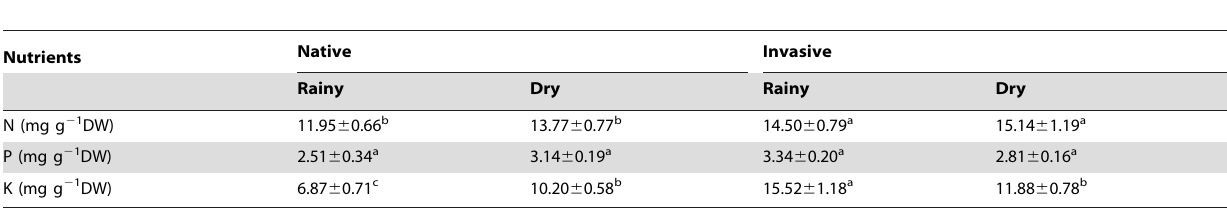
Table 2. Nutrient content in leaves of native ( Anadenanthera colubrina ) and invasive ( Prosopis juliflora ) species in a tropical dry forest in Brazil across seasons.